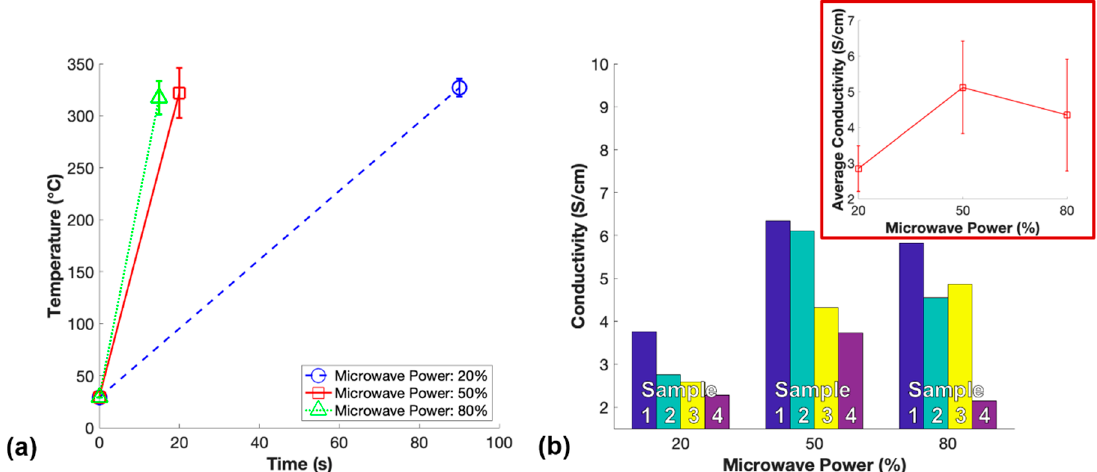
Figure 8. Power study: ( a ) Average temperature measurements after microwave curing nanocomposites with 1 wt.% CNT for one-step at variable microwave powers, and ( b ) conductivity of each set of samples for varying microwave powers used to fabricate 1 wt.% m-PDMS/CNT.